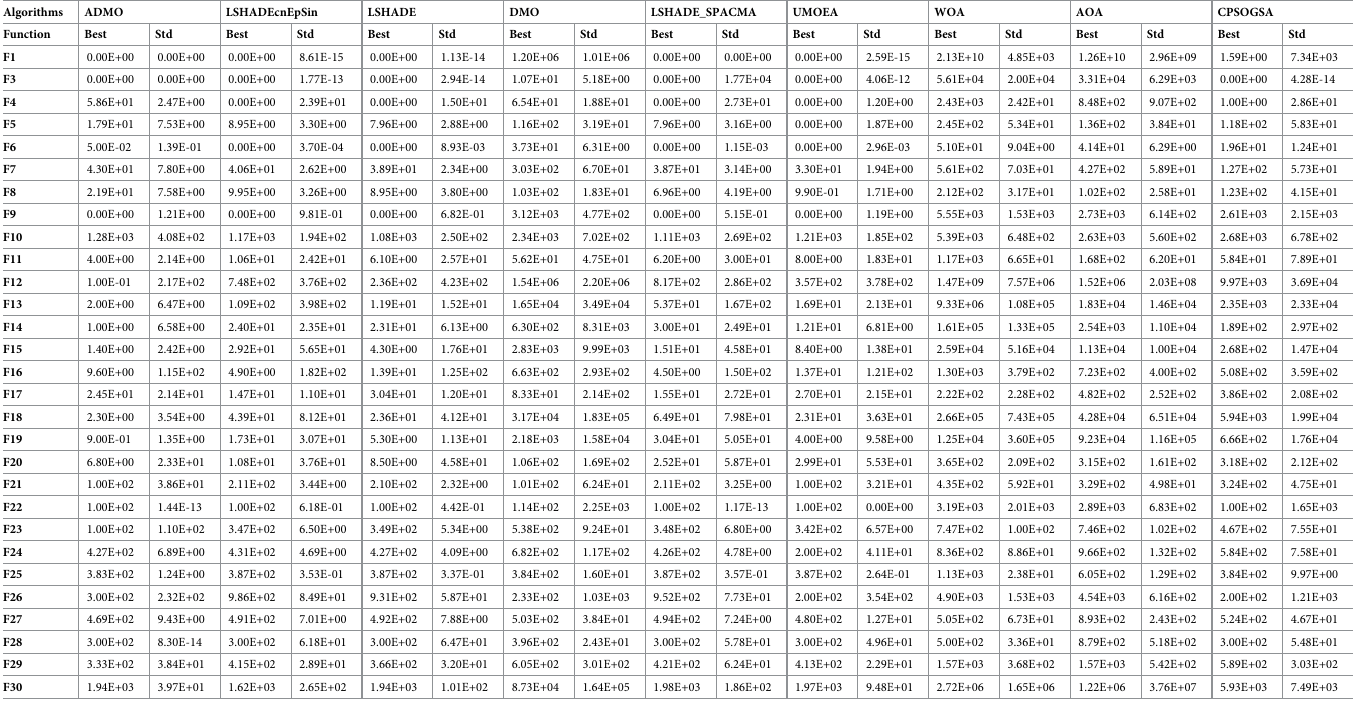
Table 11. Comparative results for 30 dimensions. Algorithms